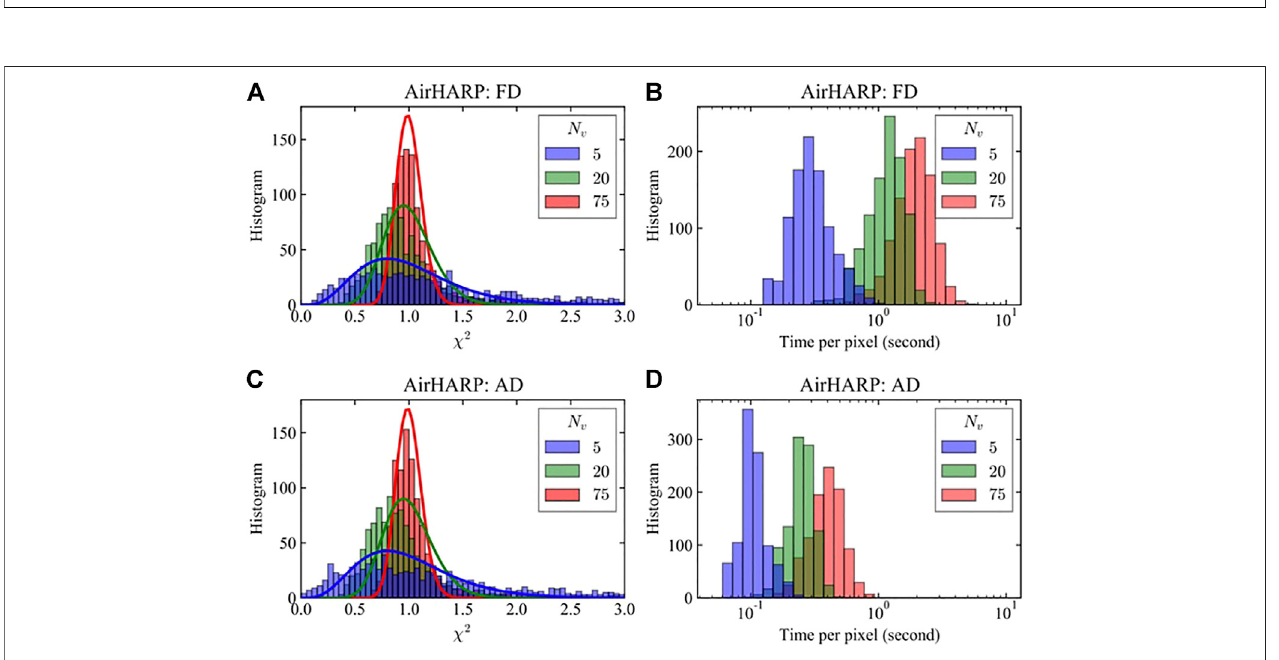
FIGURE4| Histogramsof χ 2 (AandC) andretrievalprocessingtime (BandD) forsyntheticretrievalsandvaryingnumberofviewingangles( N v )used.Solidlinesin (A) and (C) indicatethe χ 2 distributions withthe appropriate DOF equal tothe totalnumber ofmeasurements (2 N v ).FDwith central difference and AD withreverse mode are compared for both χ 2 and processing time. Viewing angles geometries are based on Figure 3C .